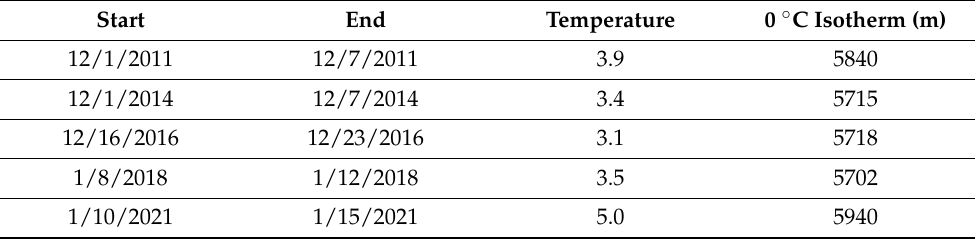
Table 2. The timing of mean temperature and mean freezing level of the only five periods in winter with an average temperature above 3 ◦ C since 1951 at Everest Base